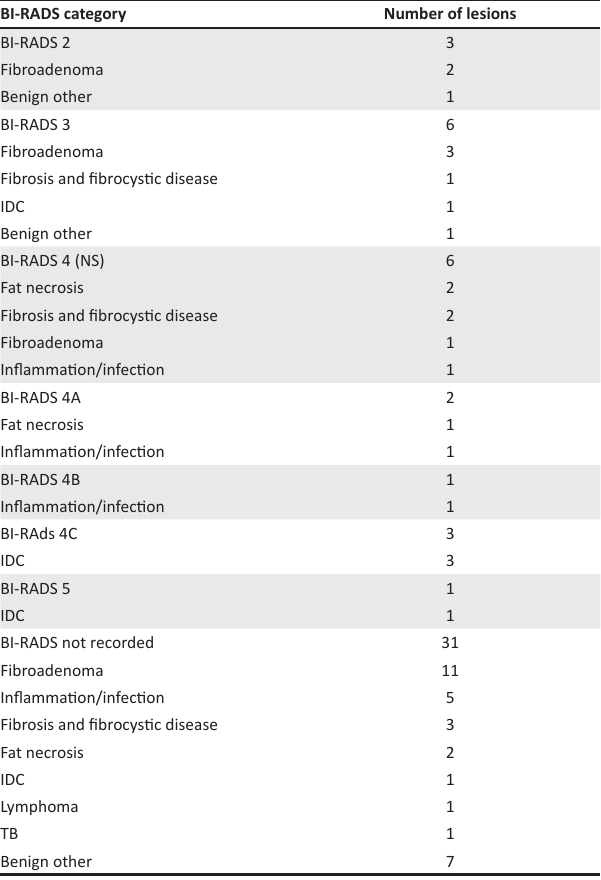
TABLE 3: Histological diagnoses of the ultrasound-guided core-needle breast biopsy in each BI-RADS category for lesions assessed with ultrasound. BI-RADS category